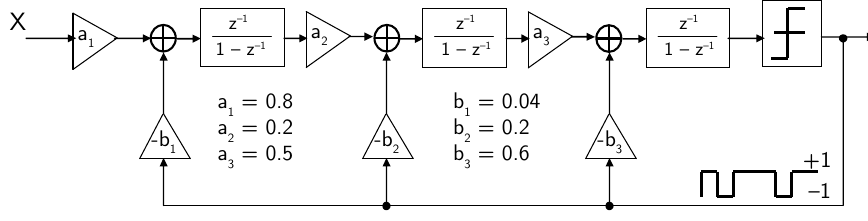
Figure 7. Block diagram of the third-order DT ΣΔ modulator (example 1).